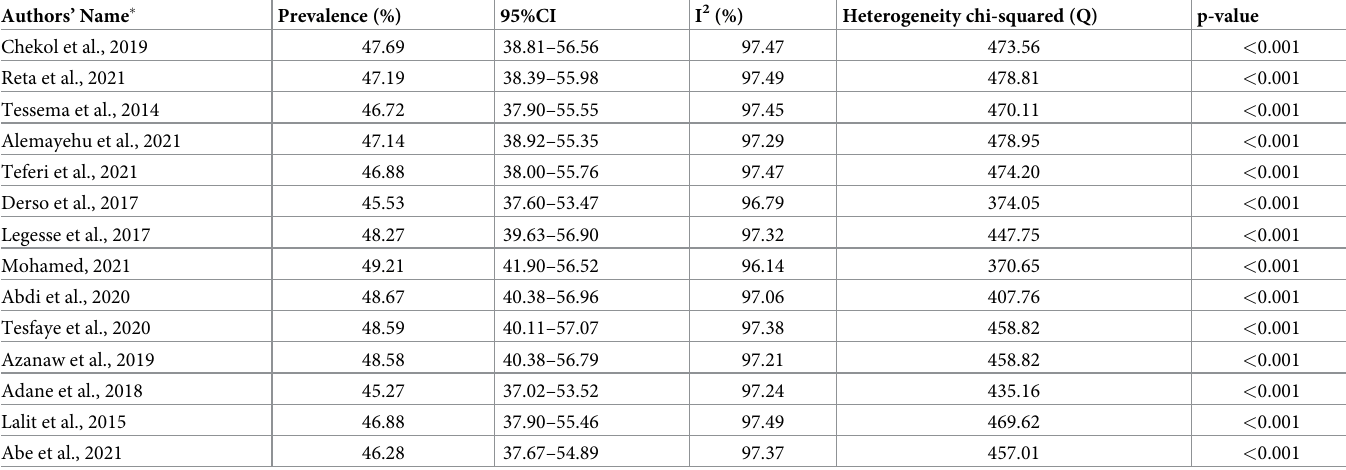
Table 3. Sensitivity analysis for estimates on safe food handling practice among food handlers in Ethiopia,